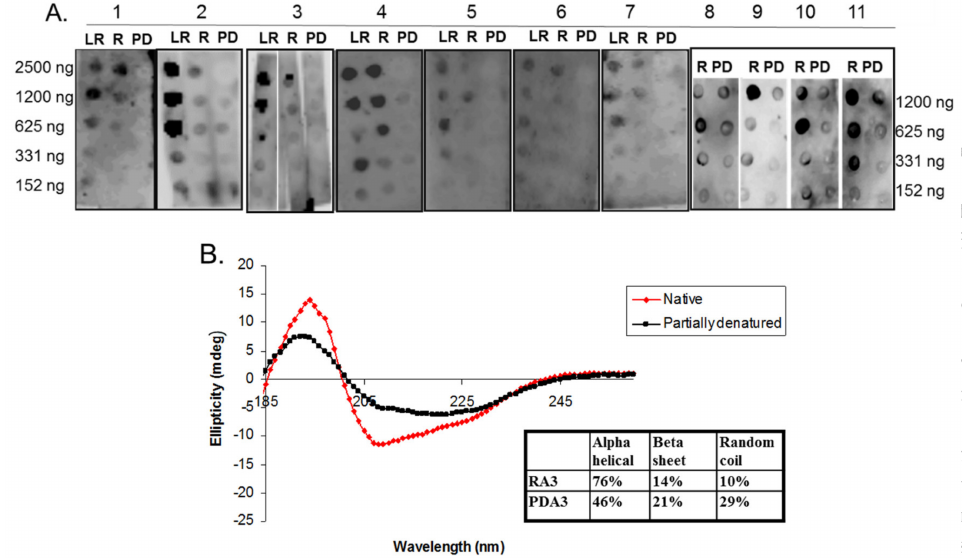
Figure 2. Circular dichroism (CD) spectra and IgE spot blot analysis of varying concentrations of light roast (LR), roasted (R) and partially denatured (PD) Ara h 3 incubated with different peanut allergic sera. ( A ) Equal and decreasing amounts (shown on each side of the blots in nanograms, ng) of each, LRA3, RA3 and PD Ara h 3 (PDA3), are spotted onto nitrocellulose membranes and incubated with individual patients’ sera indicated by number at the top; ( B ) The CD spectra of RA3 and PDA3 reported as ellipticity (on y-axis) as a function of wavelength (nm, x-axis) and the percentages of the secondary structure elements are shown in the